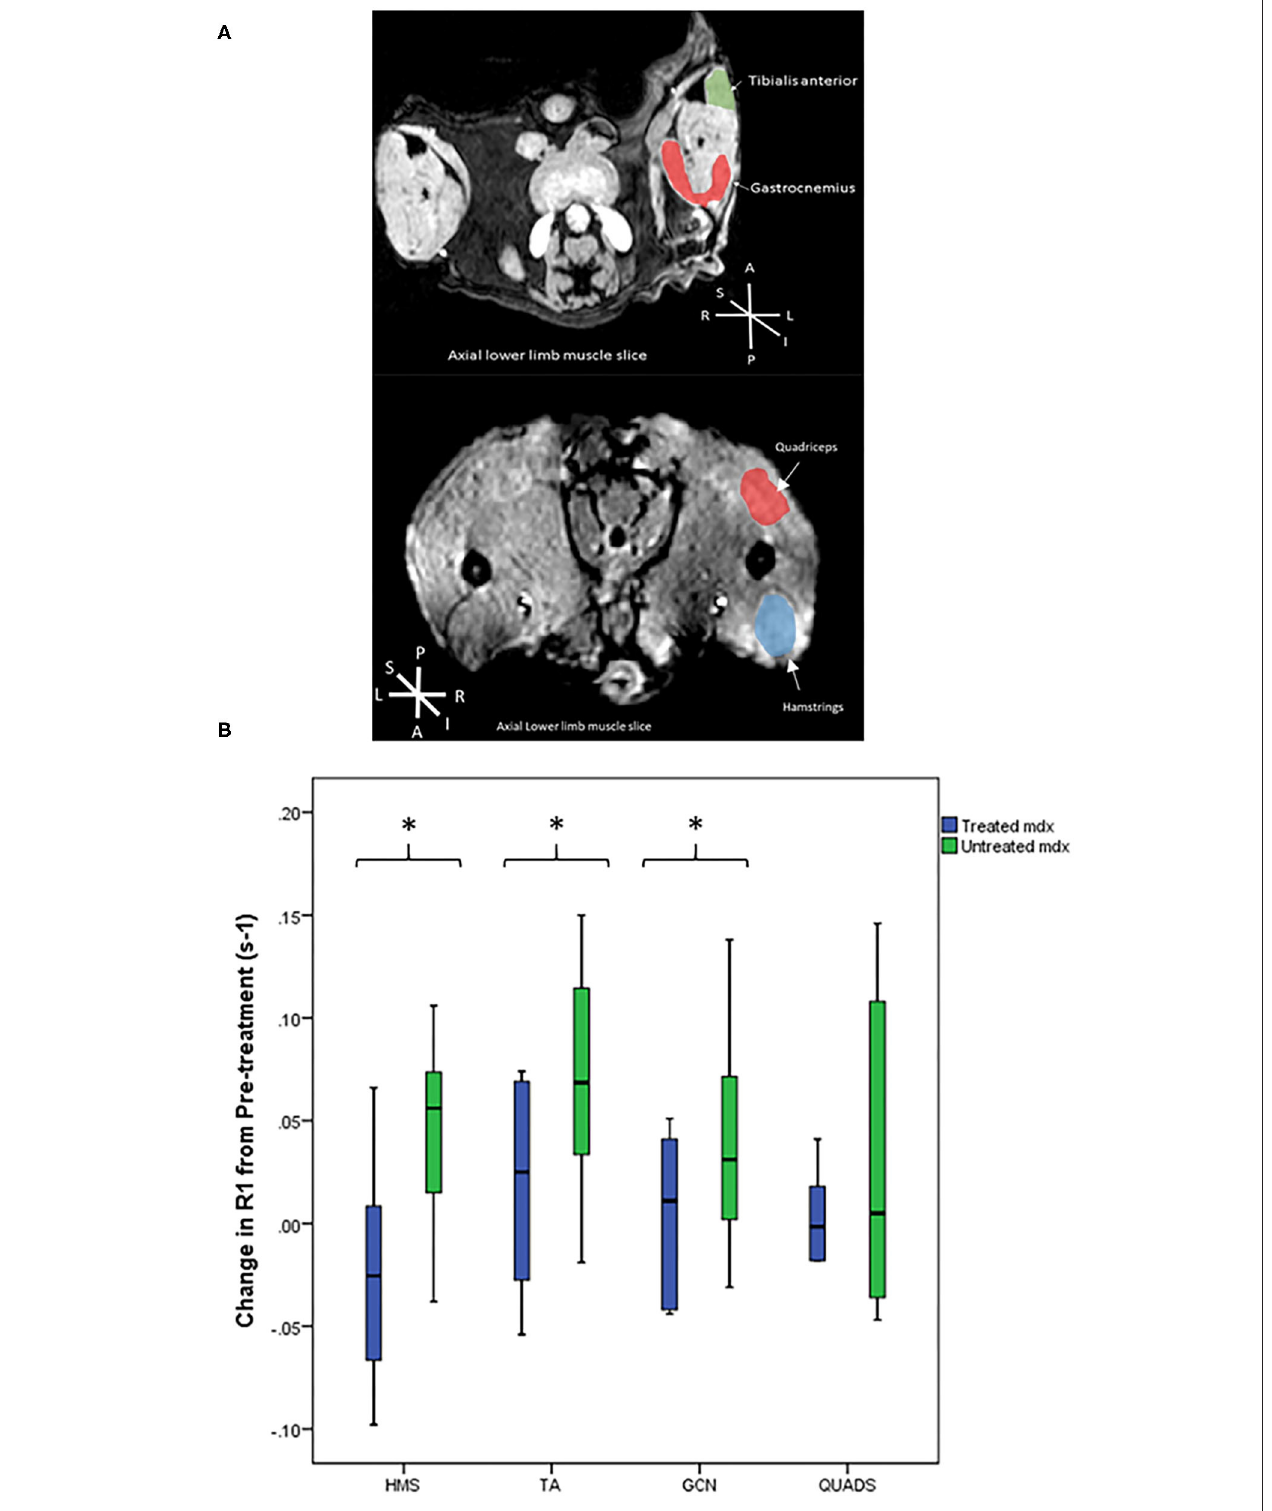
FIGURE 3 | (A) Representative T1 weighted axial MRI scans through hind limbs with regions of interest labelled. P, posterior, A, anterior, L, left, R, right, S, superior, I, inferior. (B) Box plots to compare the difference in R1 change between the mdx groups from pre-treatment to post-treatment scans. The treated mdx mice did not show significant increases in R1 post-treatment whereas the untreated mdx group showed significant increases in R1 change over time in all three muscles: gastrocnemius p = 0.04, hamstrings p = 0.009, and tibialis anterior p = 0.01. * p < 0.05, GCN, Gastrocnemius, HMS, Hamstrings, QUADS, Quadriceps, TA, Tibialis